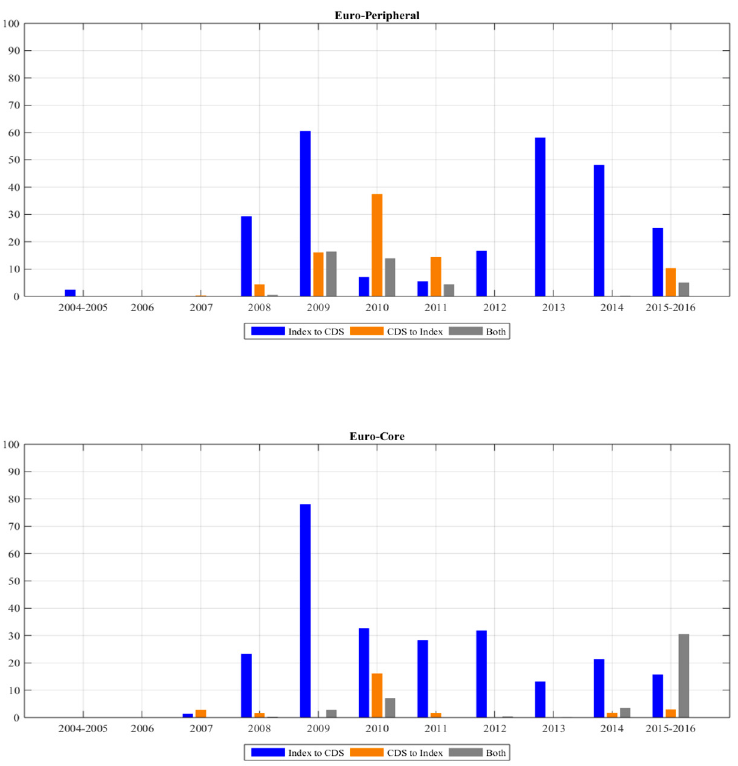
Figure 4. Granger causality test results by year and zones between stock indices and sovereign CDS returns during the period 6 January 2004–12 April 2016. For each zone and year, we present the number of times (in percentage) that the null hypothesis of Granger causality is rejected. We present results together for 2004–2005 and 2015–2016 due to the limited data available for 2004 and 2016 (the rolling estimation starts on 24 / 12 / 2004 and finishes on 12 / 4 / 2016). Blue, orange and grey bars show if the stock market Granger-causes sovereign CDS returns, vice versa or both.